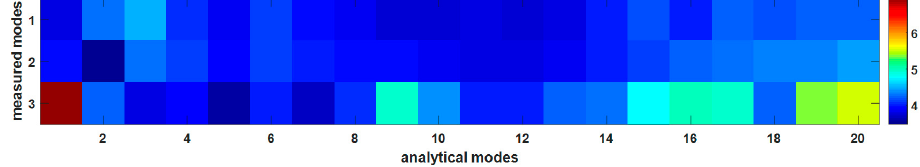
Figure 9. Sensitivity index of damage case B versus MCs N i = 20 and N j = 3, at a 3% level of noise.